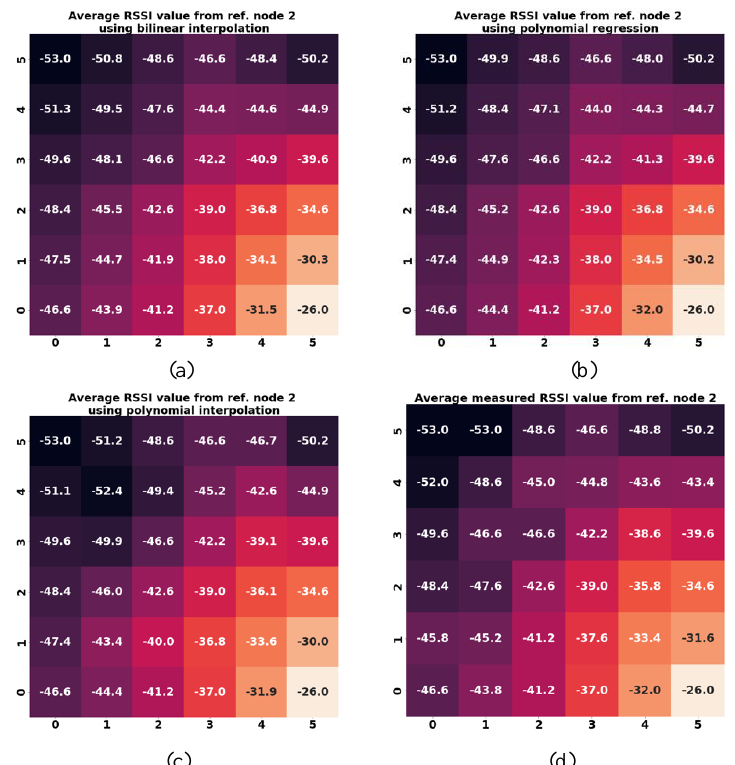
Figure 18. RSSI heatmap reference node 2. a) Bilinear inter., b) Polynomial reg., c) Polynomial inter., d) Measurement